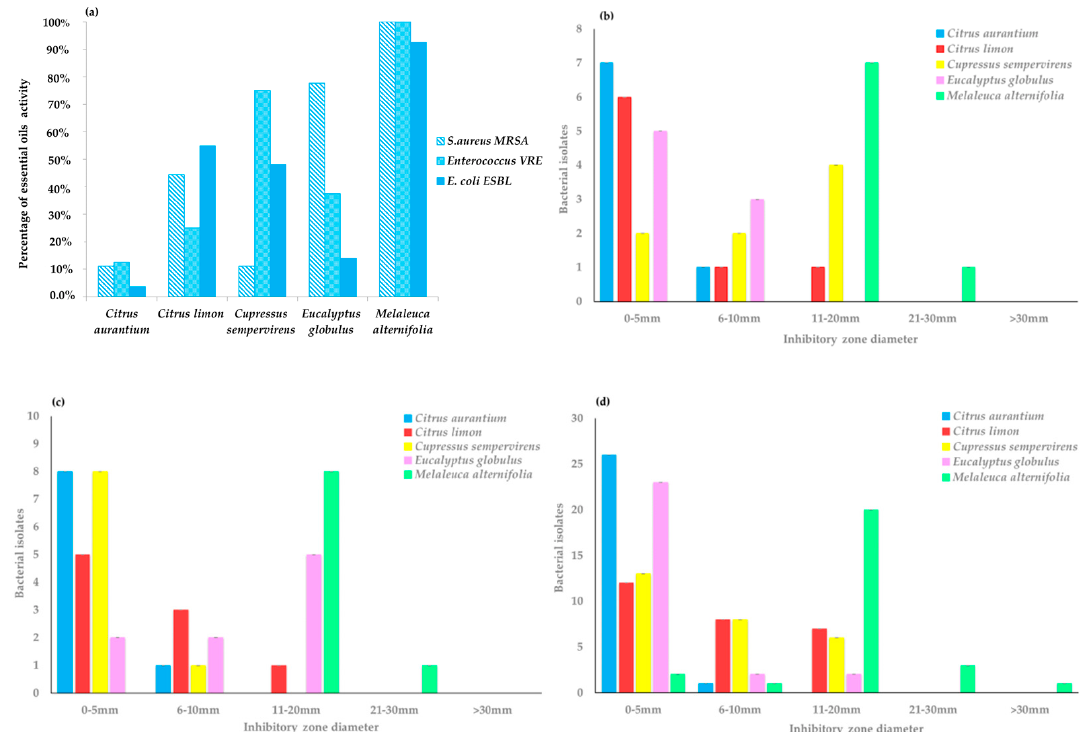
Figure 1. Antibacterial activity of essential oils (EOs) verified using the agar well diffusion method. Percentage of activity against tested antibiotic-resistant strains ( a ). Ranges of inhibitory zone diameter for VRE ( b ), MRSA ( c ), and ESBL-producing E. coli ( d ) strains. Table 3. Minimum inhibitory concentration (MIC) of EOs (µg/mL) against VRE and MRSA strains. Strains